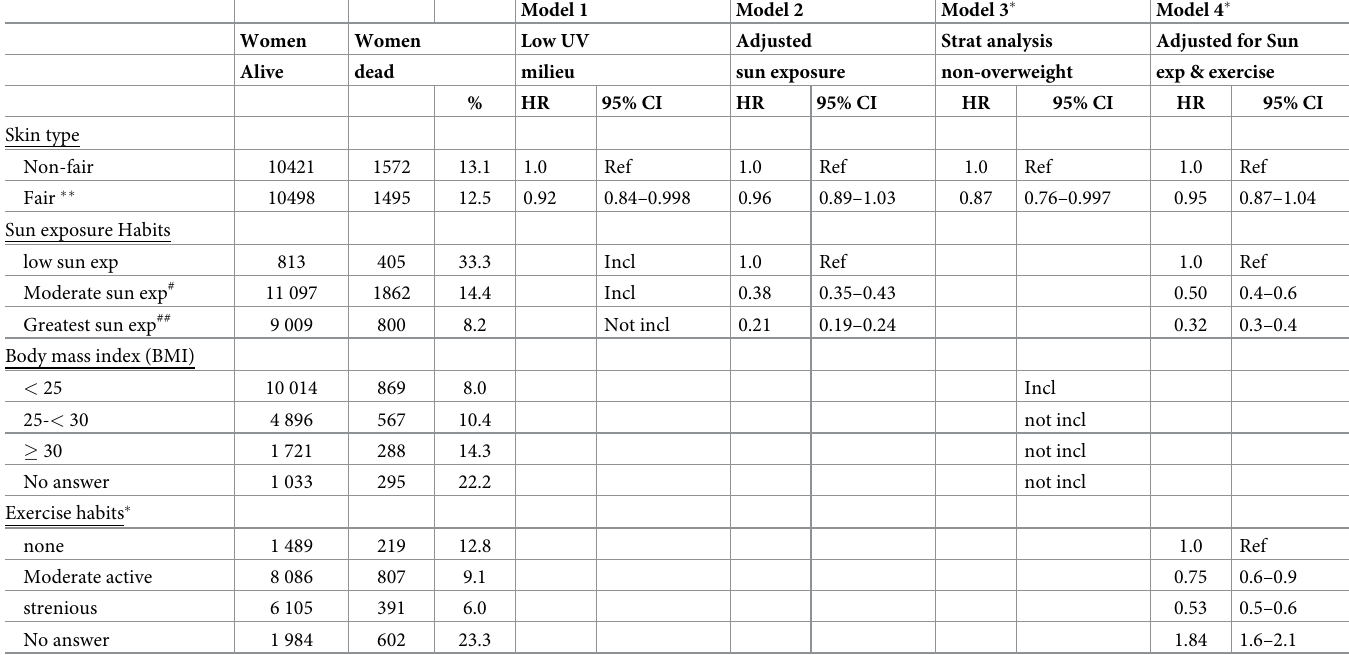
Table 2. Hazard ratios (HR) for all-cause death among women included in the nested matched case-control study both from inception 1990 (model 1 and 2) and in model 3 and 4 also data from year 2000 regarding all-cause